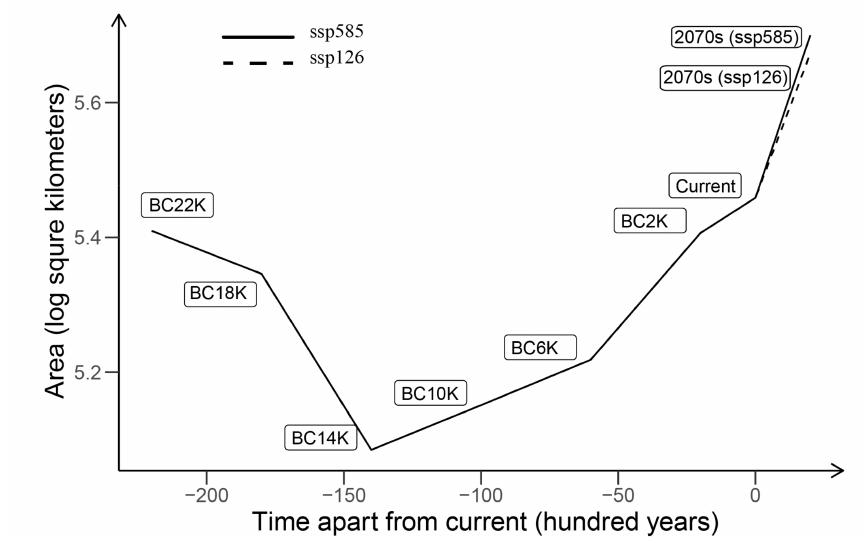
Figure 5. Area of different regions since the Last Glacial Maximum to the